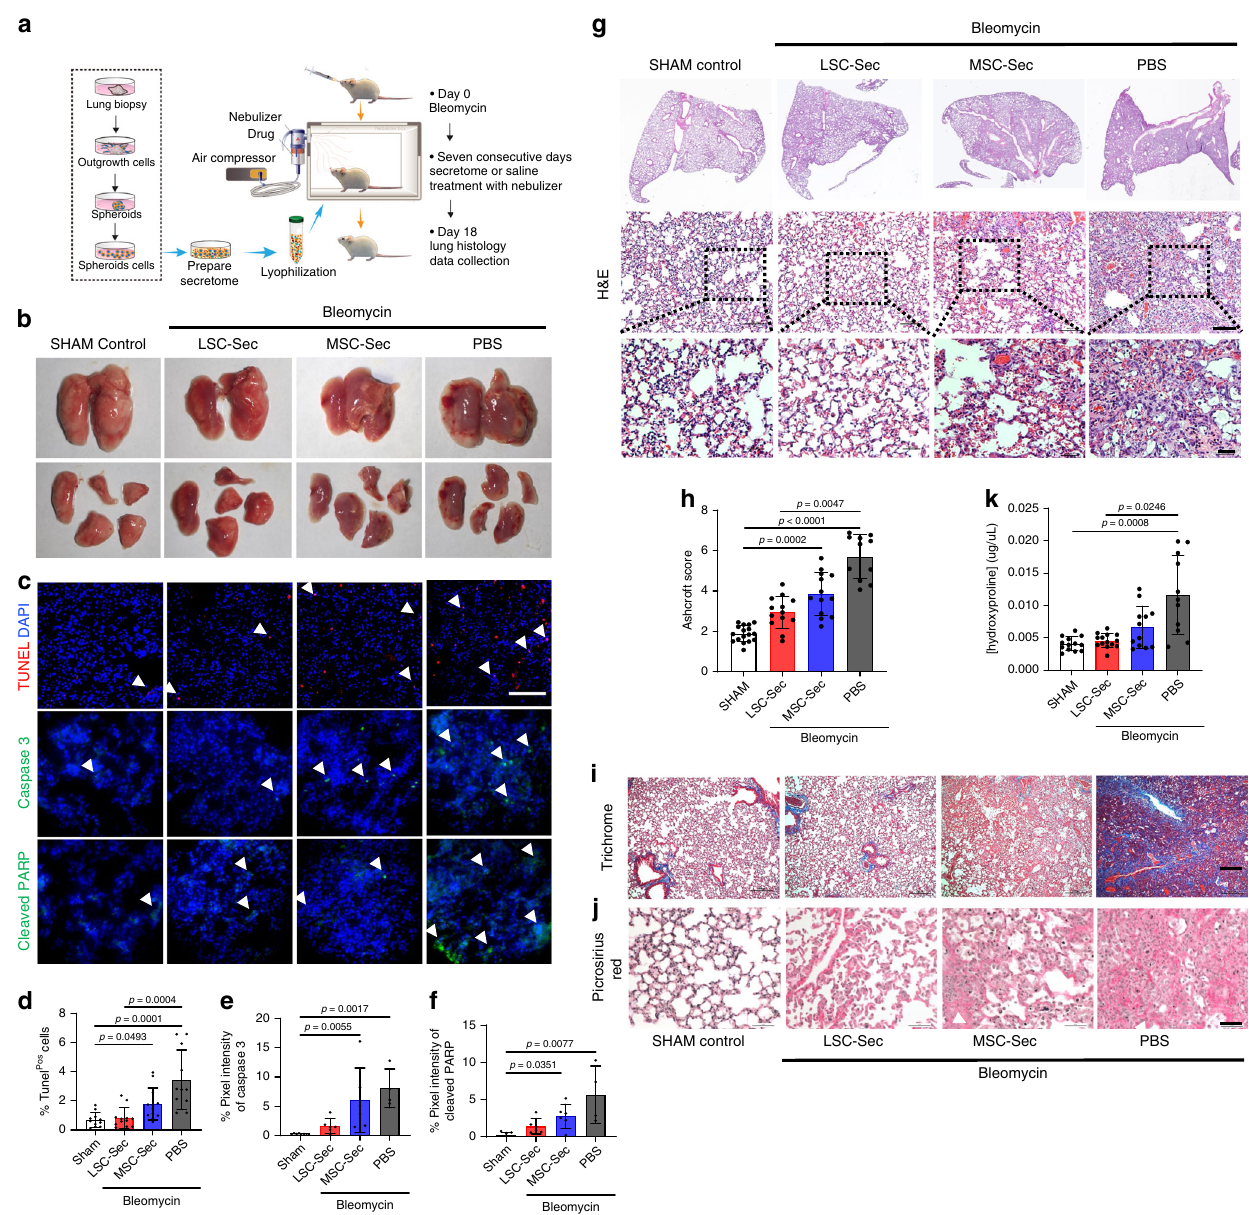
Fig. 1 LSC-Sec inhalation reverses alveolar epithelial cell damage caused by Bleomycin injury. a The schematic of LSC-Sec procedure and study design; n = 12 biological independent animals per group. b Macroscopic view of the explanted lungs at study endpoint. c Representative TUNEL (top), Caspase 3 (middle), and cleaved PARP (bottom) immunostaining of apoptotic cells for each treatment group. d – f Quanti fi cation of percent of Tunel ( d ) n = 12 biological independent animals, Caspase 3 ( e ) n = 6 biological independent animals, and cleaved PARP ( f ) positive cells, n = 6 biological independent animals; Scale bar = 100 μ m; each dot represents data from one animal; n = 6 – 12. g Representative H&E staining. Top: Scale bar = 500 μ m Bottom: Scale bar = 200 μ m. h Quanti fi cation of fi brosis by Ashcroft score; each dot represents data from one animal; n = 12 biological independent animals. Ashcroft score was performed by averaging the score from two blinded and one non-blinded scorer. i Representative Gomori ’ s trichrome staining; muscle fi bers (red), collagen (blue), nuclei (black-purple), and erythrocytes (red). Scale bar = 1000 μ m. j Representative picrosirius red staining; Collagen types I and III (red). Scale bar = 50 μ m. k Quanti fi cation of pulmonary hydroxyproline levels; each dot represents data from one animal; n = 12 biological independent animals. Throughout, data are mean ± s.d. P -value as indicated by non-parametric one-way